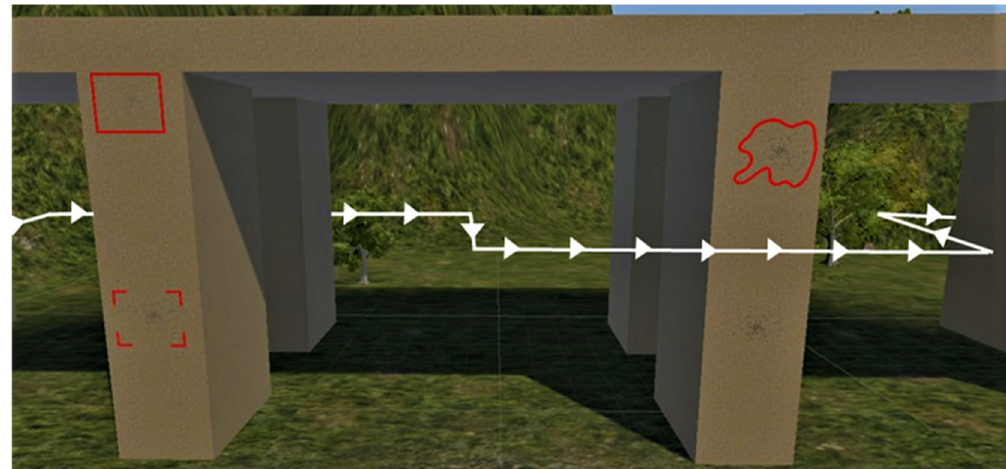
Figure 1. Simulated bridge environment with all saliency levels and augmentation types represented. The top left target is the low saliency target (0.12) with the bounding box augmentation, the bottom left target is the medium saliency target (0.17) with the corner-bound augmentation, the top right target is the high saliency target (0.22) with the outline type augmentation, and the bottom right target is the non-augmented, high saliency target. The white line denotes the movement the simulated drone made during each trial. Note that this graphic is for visual representation only and that during experimental trials, only one saliency type and one augmentation type would appear for each trial. © 2021 IEEE. Reprinted, with permission, from J. Van Dam, A. Krasner and J. L. Gabbard, “Drone-based Augmented Reality Platform for Bridge Inspection: Effect of AR Cue Design on Visual Search Tasks,” 2020 IEEE Conf. Virtual Real. 3D User Interfaces Abstr. Work. , pp. 201–204, 2020, doi:10.1109/VRW50115.2020.00040.; J. Van Dam, A. Krasner, and J. L. Gabbard, “Augmented Reality for Infrastructure Inspection with Semi-autonomous Aerial Systems: An Examination of User Performance, Workload, and System